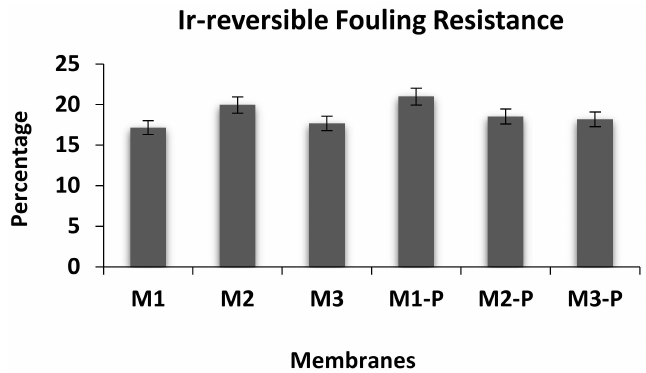
Figure 7. Fouling resistance curve of all